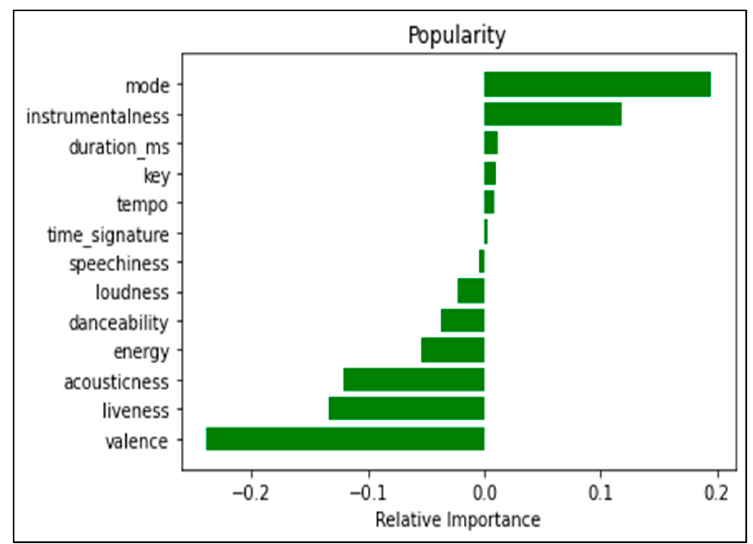
Figure 5. Variables with positive and negative correlation.